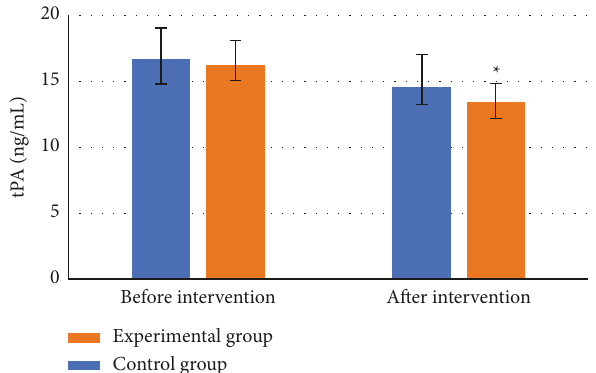
Figure 5: Comparison of tPA levels in patients’ blood. ( Note.- ∗ represents a considerable difference vs. control group, P < 0 . 05).